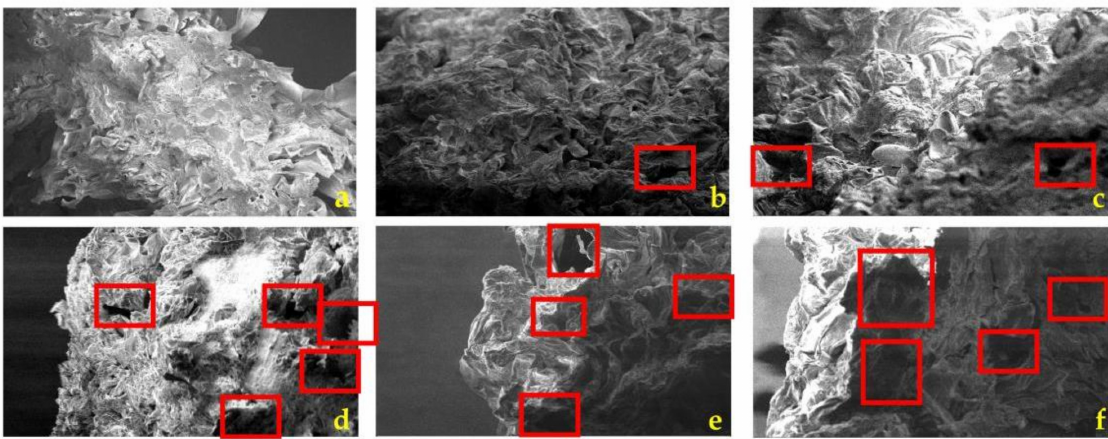
Figure 2. SEM photo of puffed CRMG × 1000 magnification: ( a ) Control; ( b ) 196.1 kPa; ( c ) 294.2 kPa; ( d )392.3 kPa; ( e ) 490.3 kPa; ( f ) 588.4